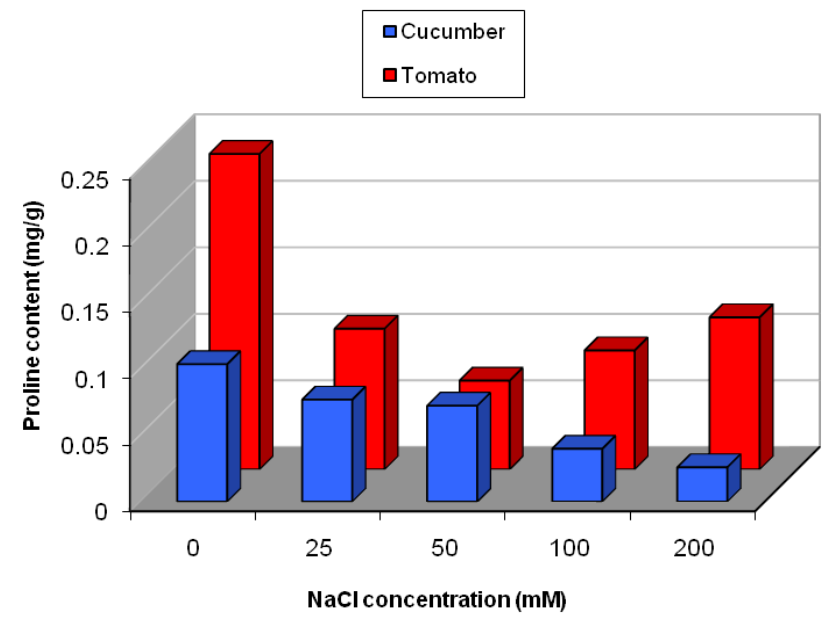
Figure 9. Proline content in cucumber and tomato under salinity stress. 2.5.2. Effect of Salinity Stress on the Content of Photosynthetic Pigments The content of photosynthetic pigments (chlorophyll a and chlorophyll b) was estimated in the leaves of cucumber and tomato and presented in Figure 10.